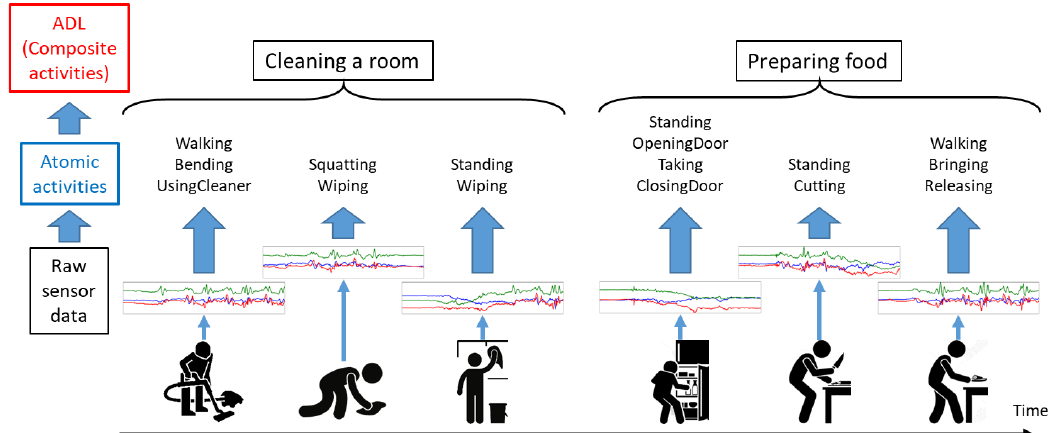
Figure 1. Hierarchical model for Activities of Daily Living (ADL) recognition. This figure depicts two examples of ADLs or composite activities, cleaning a room and preparing food. Each of the composite activities consists of several atomic activities like Bending, UsingCleaner, Squatting, Wiping, Opening Door and Cutting Food. Our hierarchical model uses raw sensory data obtained from wearable devices at its first level to detect the atomic activities performed within a short interval of time. The second level of our model recognizes composite activities based on the probabilistic scores of atomic